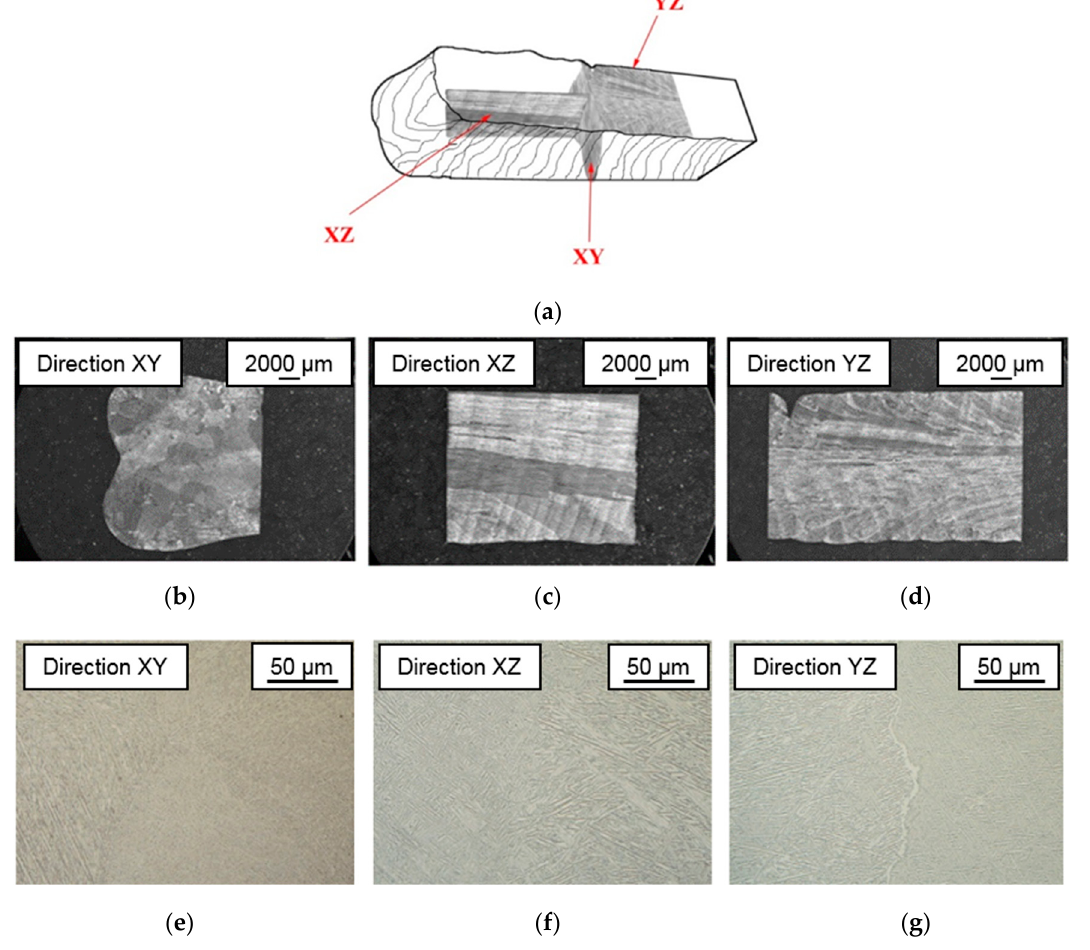
Figure 6. Macrographs and microstructure of the wall manufactured by PAW-WAAM in every direction. ( a ) General view of the planes; ( b ) macrograph on XY direction; ( c ) macrograph on XZ direction; ( d ) macrograph on YZ direction; ( e ) microstructure on XY direction; ( f ) microstructure on XZ direction and ( g ) microstructure on ZY direction.